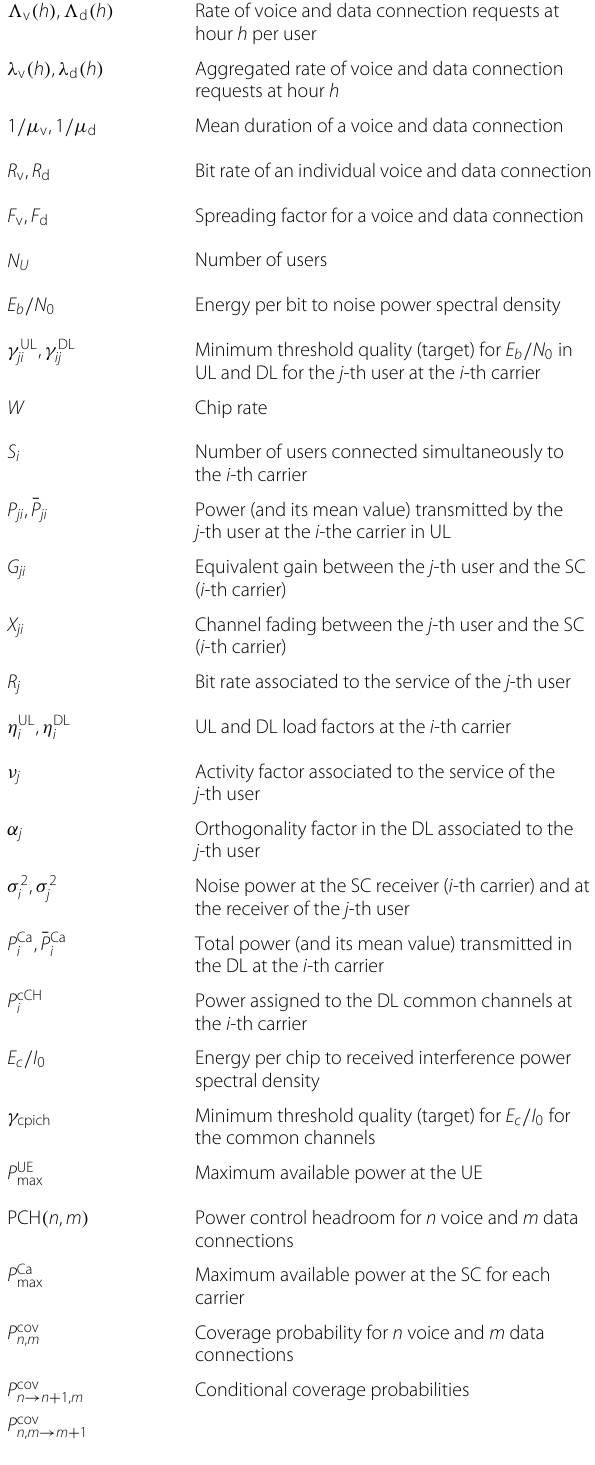
Table 6 List of parameters and symbols used in the